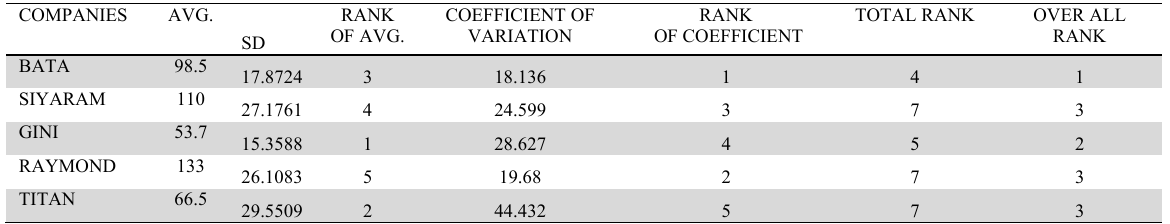
Ranking on the basis of Average and Consistency of Cash conversion Cycle of the Selected Companies of Retail